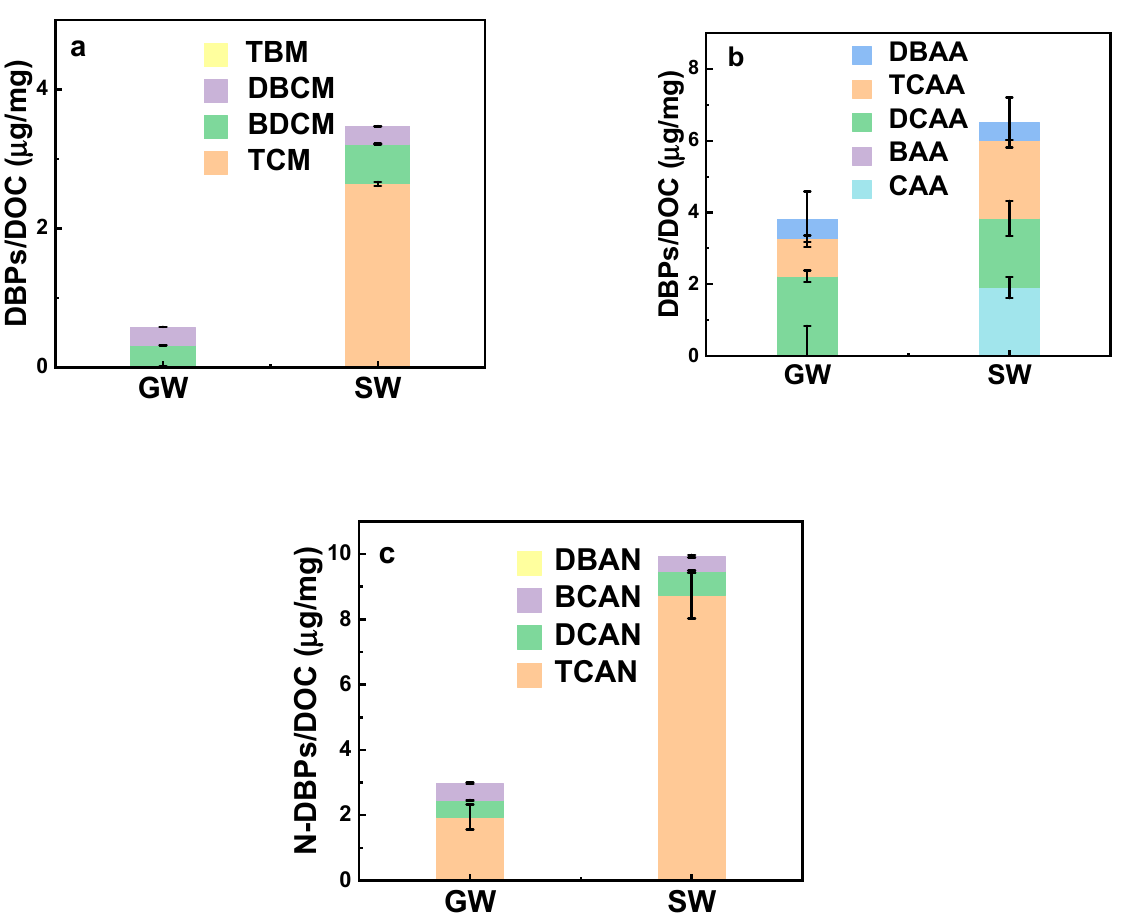
Figure 5. The DBPFP of the GW and SW by chloramine disinfection: ( a ) THMs; ( b ) HAAs; ( c ) HANs. The CI of the GW and SW under chlorine and chloramine disinfection were also calculated as shown in Figure 6. Similarly, the CI of the GW and SW was dominated by the HANs. The HAAs and THMs contribute a little to the CI index. Generally, the CI indexes of the chloramine disinfection were significantly lower than those of the chlorine disinfection, especially for the GW by the chloramine disinfection. The CI index of the GW under chloramine disinfection was less than 10 × 10 4 , which was only one third of that under chlorine disinfection, which suggested that the NOM in the GW water was less reactive to the chloramine compared with chlorine. As discussed in Section 3.2, the DOM in the GW was mainly the tyrosine and tryptophan-like organic matter and microbial by-product-like substance. The GW did not contain any HA-like materials, which might indicate that the HA-like substance was more reactive to chlorine as well as chloramine, and therefore the DBPFP per mg DOC of the SW was much higher than that of the GW.